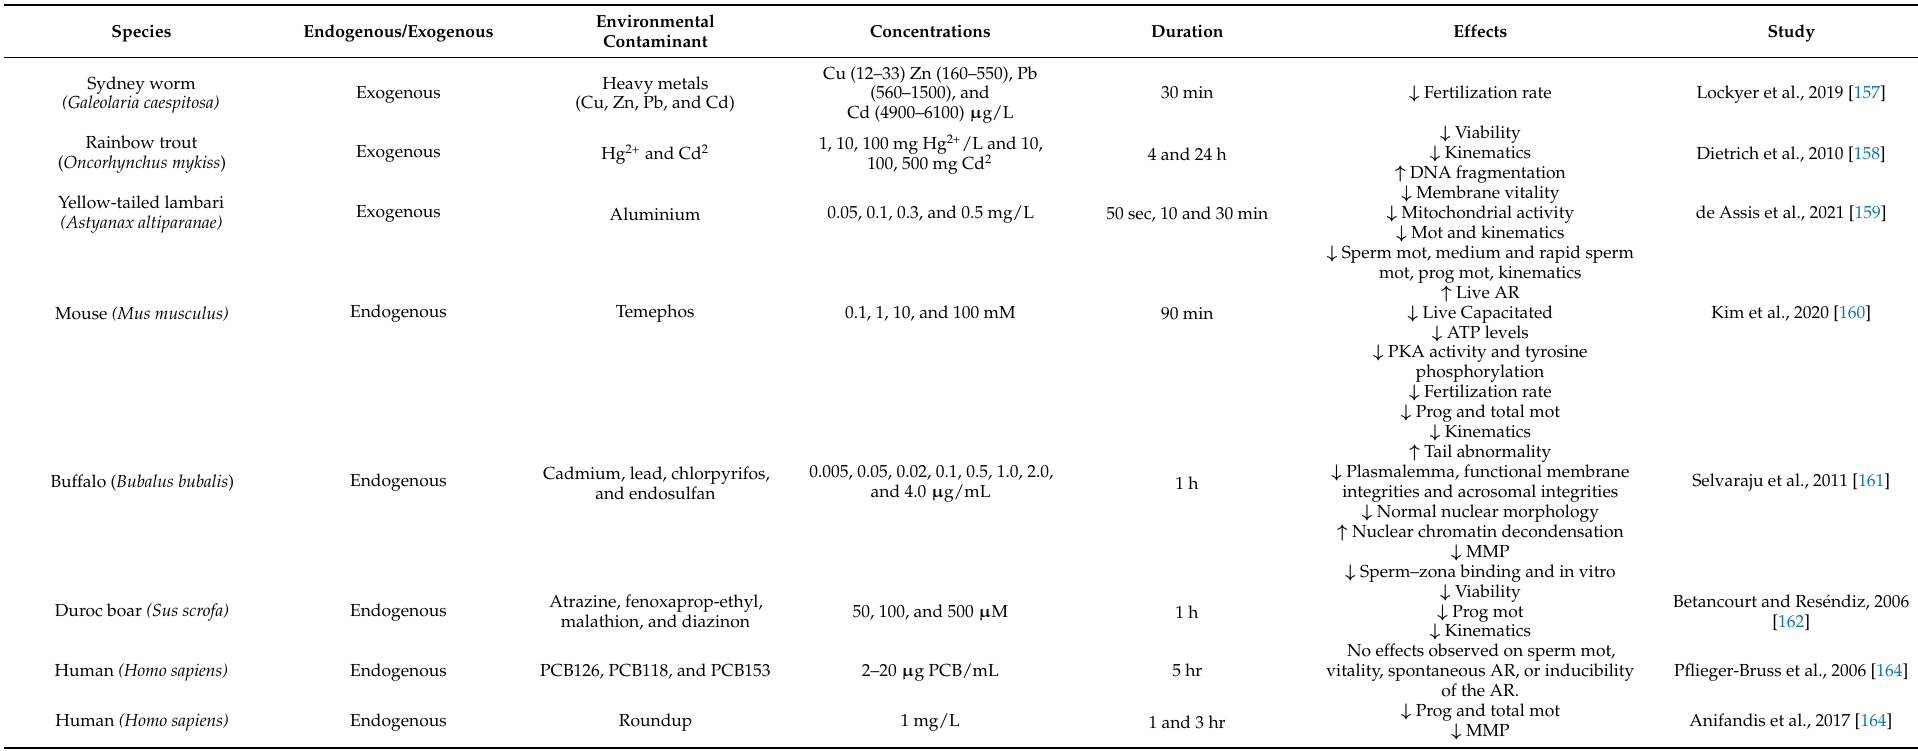
Table 2. Studies using spermatozoa as a bio-indicator to evaluate the effect of various environmental contaminants on male fertility of various species, including examples of exogenous and endogenous fertilization